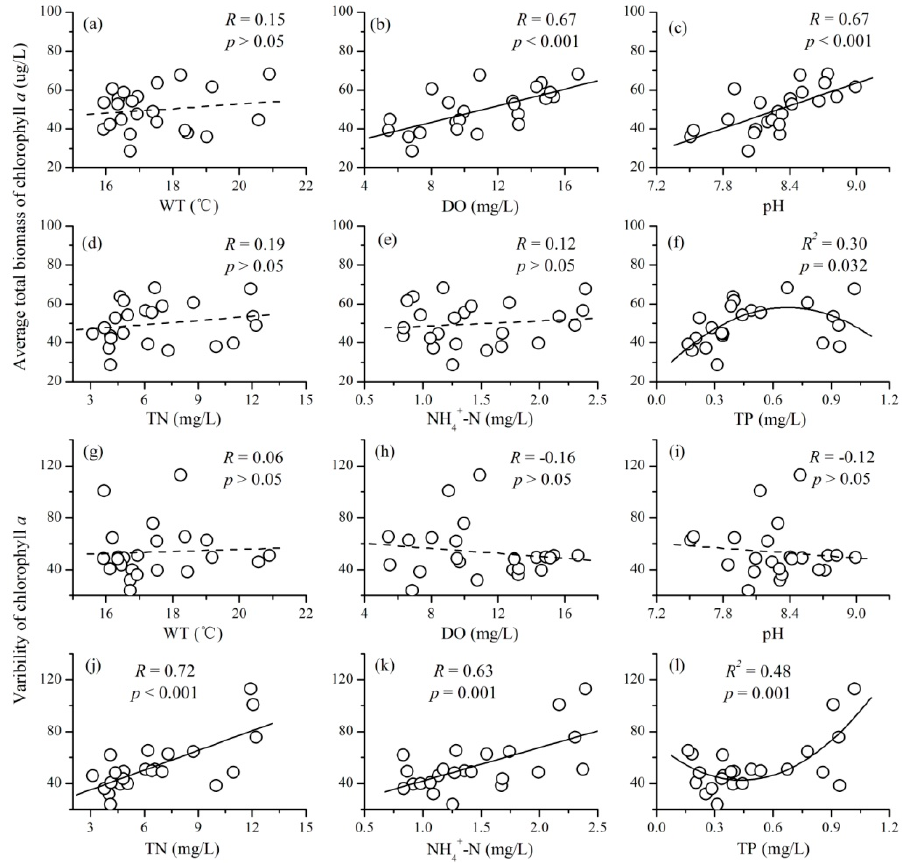
Figure 6. The relationships between the mean values of ( a ) water temperature (WT); ( b ) dissolved oxygen (DO); ( c ) pH; ( d ) total nitrogen (TN); ( e ) ammonia nitrogen (NH 4+ ‐ N); ( f ) total phosphorus (TP) and the average total biomass of phytoplankton. Figures ( g – l ) are the relationships between the mean values of the six environmental factors and the variability of phytoplankton biomass (chlorophyll a ) in the lake. The fitting of regression equations is calculated using the 23 sample sites in the lake (all N = 23).